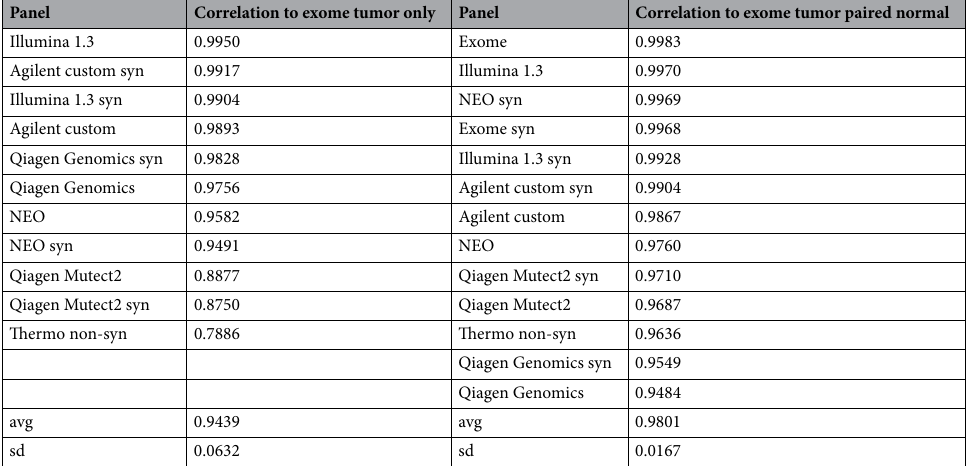
Table 2. Comparison of the correlation for the different gene panels and analysis methods. Exome tumor only analysis for the different gene panels and analysis methods (N = 14) and exome tumor paired normal analysis for the different gene panels and analysis methods (N = 7). Panels: Illumina—TSO500; NEO—NEOplus v2 RUO TMB (NEO New Oncology); Agilent custom—custom panel Agilent SureSelect XT HS, Exome